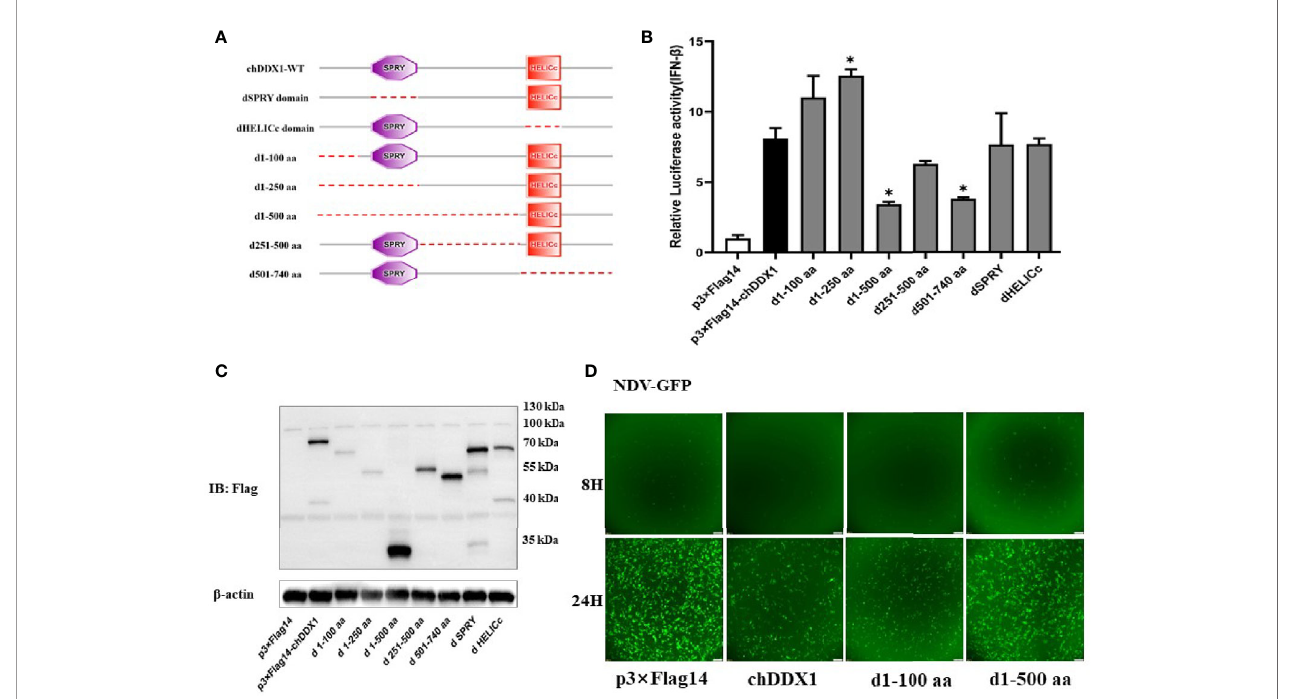
FIGURE 5 | Essential domains of chDDX1 for IFN- b promoter activity. (A) Schematic structure of chDDX1 mutants. (B) The effects of chDDX1 truncated mutants on IFN- b promoter activity. (C) Western blots for expression of the truncated chDDX1 protein. (D) NDV-GFP Virus Proliferation in DF-1 cells transfected with